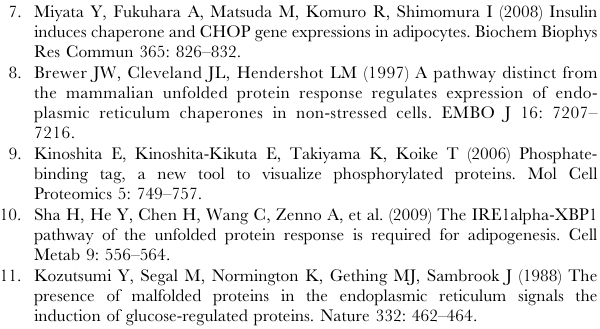
Figure S1 Immunoblots of p-Thr980 PERK, IRE1 a (left) and total PERK (right) in different MEFs treated with or without Tg. (left) IRE1 a 2 / 2 and PERK 2 / 2 MEFs were used; (right) wildtype ( + / + ), PERK 2 / 2 ( 2 / 2 ) and PERK 2 / 2 MEFs rescued with wildtype PERK ( 2 / 2 + wt). Figure S2 (A) Immunoblots of IRE1 a (top) and PERK (bottom) in various tissues of wildtype mice under feeding conditions, an independent experiment from the one shown in Figure 3A. WAT, white adipose tissues; Panc, pancreas; Muscle, gastrocnemius. (B) Original Phos-tag whole-gel images for the data shown in Fig. 3B. Note the specificity of the antibody and the complete reverse of phosphorylation upon phosphatase treatment. (C) Immunoblots of IRE1 a and PERK in muscle lysates treated with l PPase. The multiple bands of IRE1 a in the muscle are not due to hyperpho- sphorylation and PERK protein levels are beyond detection limit. (D) Immunoblots of IRE1 a and PERK in lysates extracted from different regions of the pancreas of 13-week-old wildtype mice under the 20 h-fasting (F) and 2 h-refeeding (R) conditions. The position of the pancreas is relative to the duodenum (proximal, middle or distal) - see the diagram on top. HSP90, a loading control. Phos-tag gels are indicated with a bar at the left-hand side. Found at: doi:10.1371/journal.pone.0011621.s002 (0.35 MB JPG) Table S1 Primers used in this